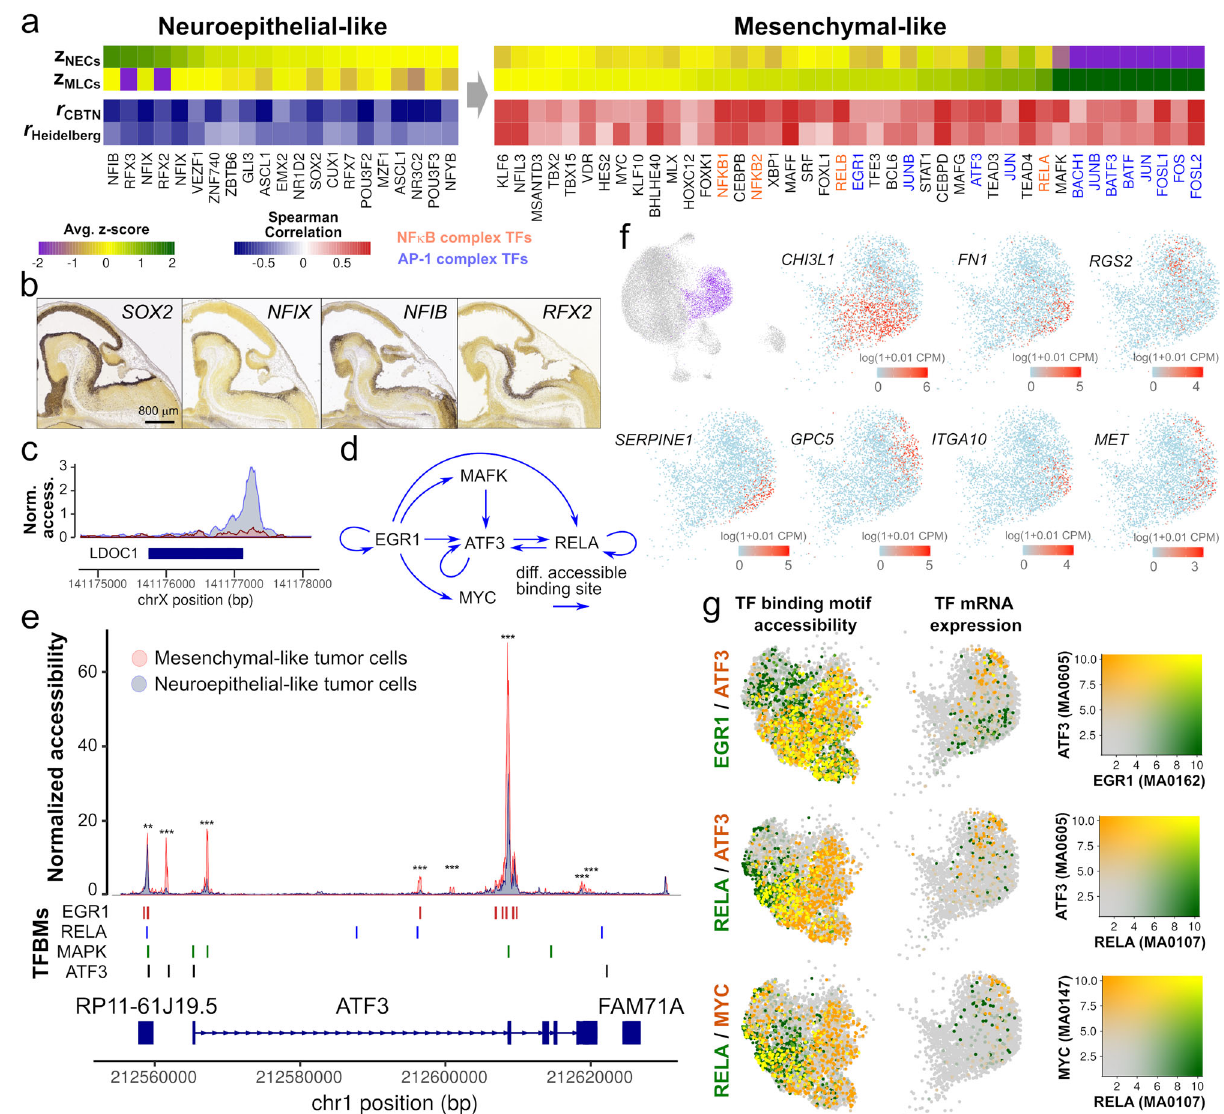
Fig. 4 The transition of posterior fossa ependymoma tumor cells into a mesenchymal-like state involves the inhibition of neuroepithelial transcription factors and the activation of the NF κ B and AP-1 complexes. a Differentially expressed transcription factors in the neuroepithelial- or mesenchymal-like tumor cell populations that have differentially accessible binding motifs across the EMT (FDR < 0.1). The heatmap shows the transcription factor binding motif score in the neuroepithelial ( z NECs ) and mesenchymal-like ( z MLCs ) cell tumor cell populations according to the single-nucleus ATAC-seq data, and the Spearman ’ s correlation coef fi cient between the inferred abundance of MLCs and the expression level of the transcription factor in the CBTN ( r CBTN ) and Heidelberg ( r Heidelberg ) bulk RNA-seq cohorts. Transcription factors that are part of the NF κ B and AP-1 complexes are indicated in orange and blue, respectively. b Whole-mount RNA in situ hybridization of sagittal sections of E13.5 mouse embryos, showing the expression of neuroepithelial transcription factors in the neuroepithelum of the brainstem and isthmic organizer (Image credit: Allen Institute). c Normalized chromatin accessibility pro fi le at the LDOC1 locus for neuroepithelial-like and MLC populations, showing the inaccessibility of the promoter in MLCs. d Inferred regulatory network between some members of the MAF/BACH, NF κ B, and AP-1 complexes. Arrows from one transcription factor into another indicate the presence of at least one differentially accessible binding motif of the fi rst transcription factor in the gene locus of the second transcription factor (Fisher ’ s exact test, FDR (cid:3) 0 : 05). This analysis indicates ATF3 integrates signals from the AP-1, ERK, MAF/BACH, and NF κ B signaling pathways. e Normalized chromatin accessibility at the ATF3 gene locus for neuroepithelial- and mesenchymal-like tumor cells, where the binding sites of EGR1, RELA, MAPK, and ATF3 are indicated. Transcription factor binding sites are differentially accessible between the neurepithelial- and mesenchymal-like cell populations. (Two-sided Fisher ’ s exact test; *FDR (cid:3) 0 : 05, **FDR (cid:3) 0 : 01, ***FDR (cid:3) 0 : 001). Numeric q values are provided in the Source Data fi le. f The part of the UMAP representation corresponding to the MLC population is colored by the expression level of several genes with signi fi cantly heterogeneous expression within that cluster (Laplacian score, FDR < 0.01) based on a spectral graph method. g The part of the single-nucleus ATAC-seq and RNA-seq UMAPs that corresponds to the MLC population is colored by the transcription factor binding motif accessibility score and the gene expression level of RELA, ATF3, EGR1, and MYC transcription factors. In the fi gure, a substantial amount of heterogeneity is observed within the MLC population, and the relative patterns of expression and motif accessibility are consistent between the single-nucleus RNA-seq and ATAC-seq representations. MLCs mesenchymal-like tumor cells, NECs neuroepithelial-like tumor cells, TFBMs transcription factor binding